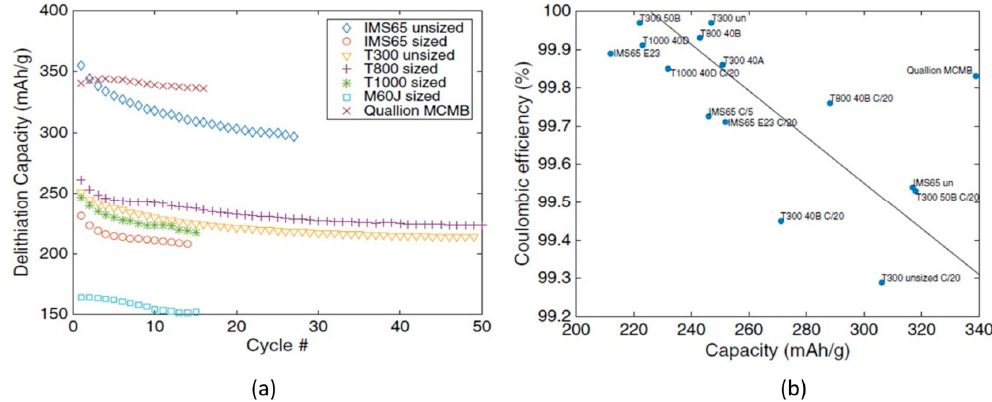
Figure 17. Polyacrylonitrile (PAN)-based fiber electrical performance and comparison with MCMB [61]. ( a ) Delithiation capacity vs. cycle number for PAN-based fiber cycled at C/10. ( b ) 10th cycle Coulombic efficiency against specific capacity.